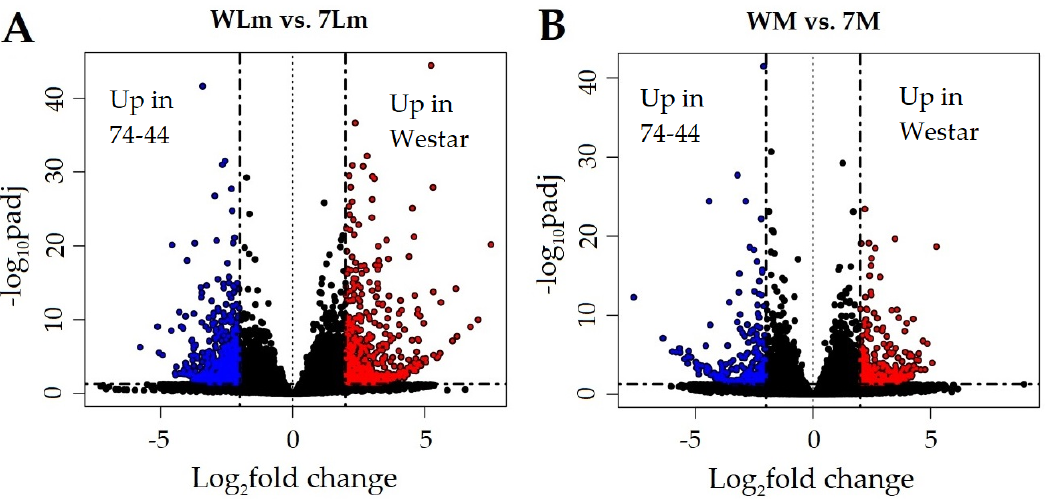
Figure 5. Volcano plots of DEGs between L. maculans inoculated Westar (WLm) and 74-44 BL (7Lm) ( A ), or between mock-inoculated Westar (WM) and 74-44 BL (7M) ( B ). Red and blue dots represent up- and downregulated DEGs, respectively, while the black dots indicate non-DEGs. X-axis: Log 2 -fold change; and Y-axis: Log 10 adjusted p values.